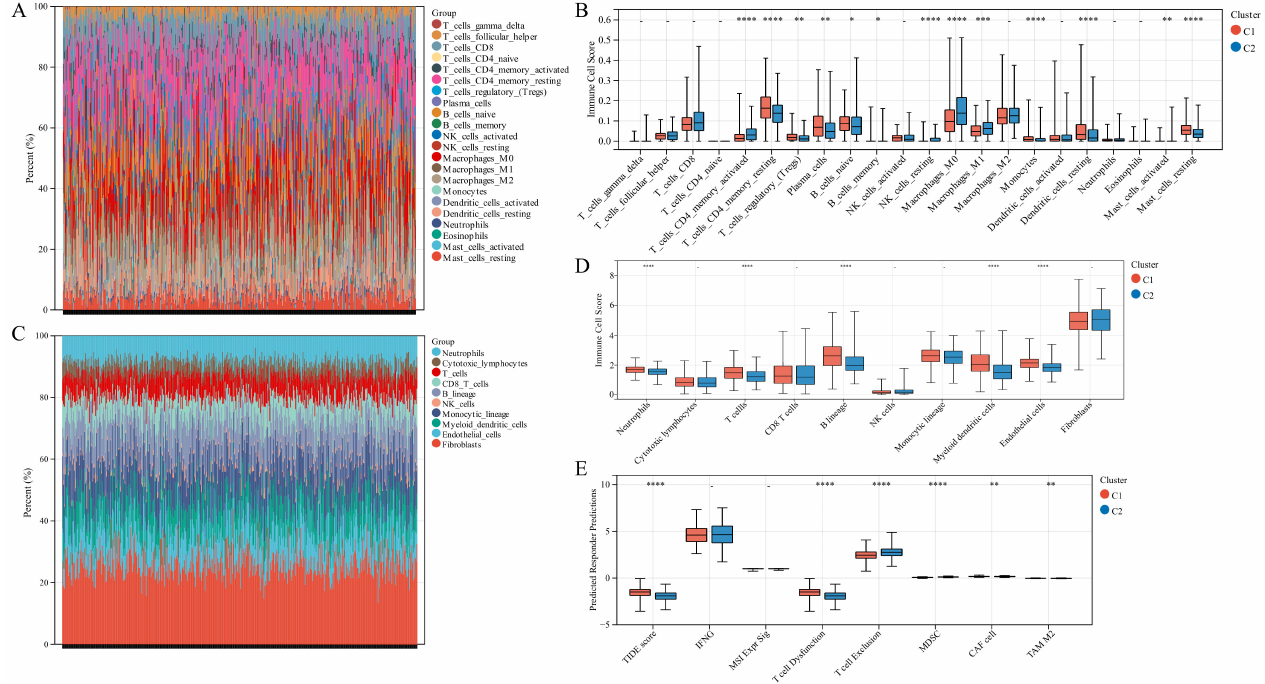
Figure 5. Immune landscape in the two TTK modes. ( A , C ) The relative proportion of immune infiltration analysed using the CIBERSORT and MCPCounter algorithms in TCGA-LUAD cohorts. ( B , D ) Box plots display the significantly distinct immunogenicity cells between various subtypes in TCGA-LUAD cohorts using the CIBERSORT and MCPCounter algorithms. ( E ) Box plots display the TIDE score for the two clusters in LUAD. Asterisks indicate significance, * p < 0.05; ** p < 0.01; *** p < 0.001; **** p < 0.0001; -, no statistical